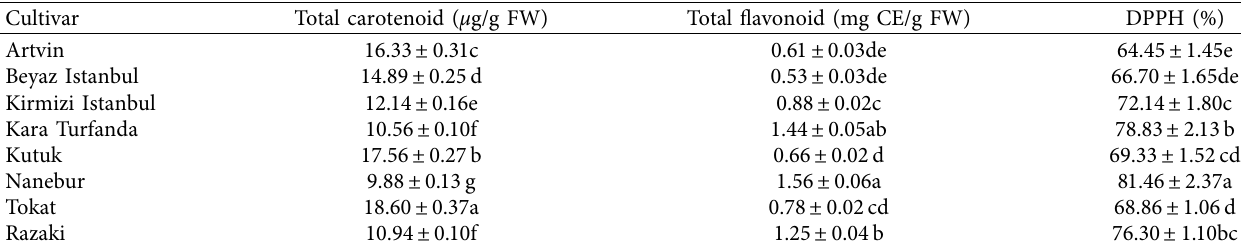
Different letters in the same column indicate statistically significant differences ( p < 0 .